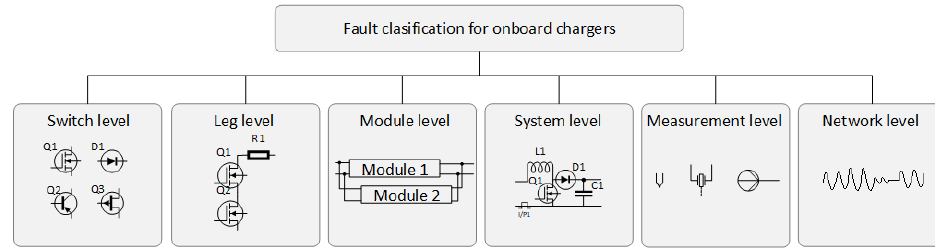
Figure 1. Fault classification for PECs/OBCs. Symbology shows common fault